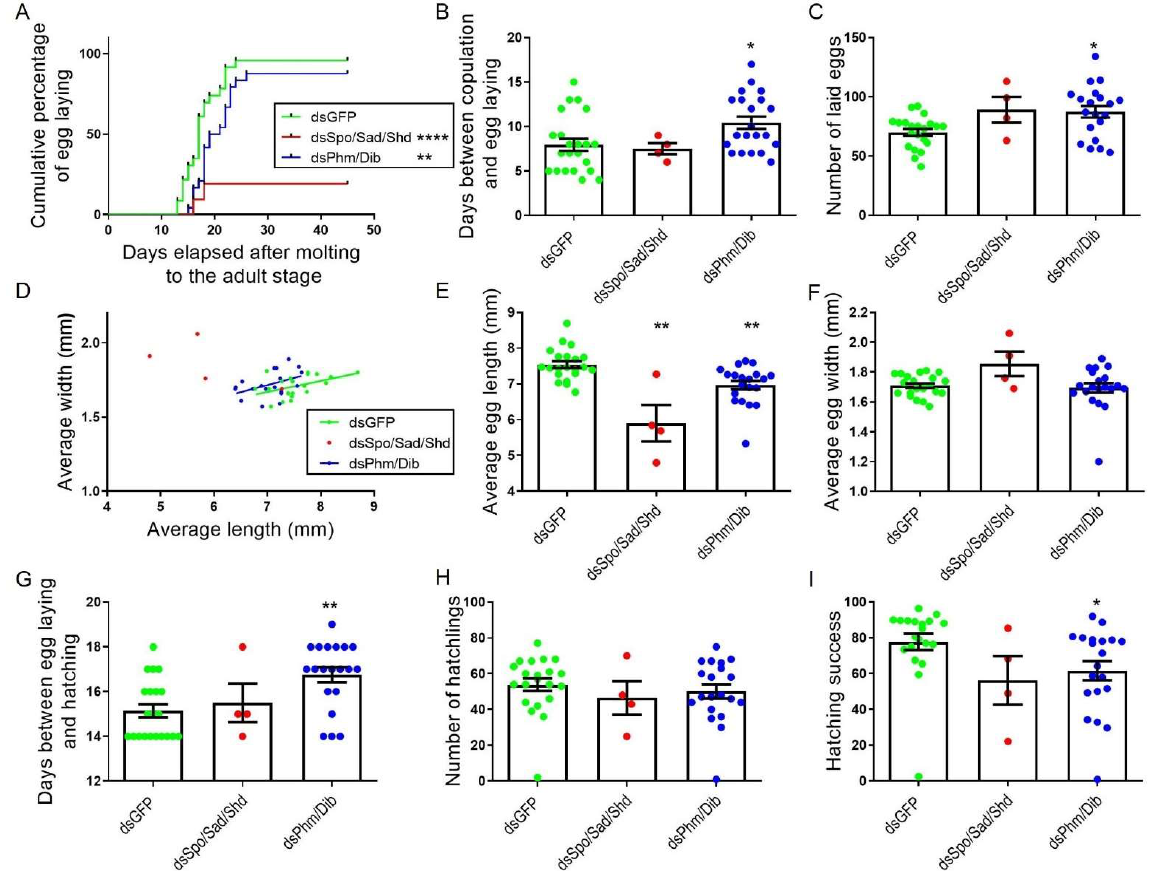
Figure 5. Effects of RNAi-mediated knockdown of SchgrSpo / SchgrSad / SchgrShd and SchgrPhm / SchgrDib on egg size, egg laying and hatching of female S. gregaria . ( A ) Cumulative percentage of egg laying by dsRNA-injected female locusts: 19.05% for dsSpo / Sad / Shd - ( n = 4), 87.5% for dsPhm / Dib - ( n = 24) and 95.65% for dsGFP -treated ( n = 23) females. The curves of dsSpo / Sad / Shd and dsPhm / Dib -treated females significantly differ from the curve of dsGFP -treated females (**** p < 0.0001 for dsSpo / Sad / Shd and ** p < 0.01 for dsPhm / Dib ; Mantel–Cox test). ( B ) The number of days between copulation and egg laying is presented as the mean ± S.E.M.; each dot represents one data point. Significant differences are indicated by (an) asterisk(s) (* p < 0.05; Kruskal–Wallis test with Dunn’s Multiple Comparisons test). ( C ) The number of eggs laid per condition is presented as the mean ± S.E.M.; each dot represents one data point. Significant differences are indicated by (an) asterisk(s) (* p < 0.05; Kruskal–Wallis test with Dunn’s Multiple Comparisons test). ( D ) The data represent the average length (Y-axis) and width (X-axis) of eggs laid by dsSpo / Sad / Shd -, dsPhm / Dib - or dsGFP -treated females (coloured dots), as well as the linear regression (coloured lines) ( dsSpo / Sad / Shd n = 4, dsPhm / Dib n = 20 and dsGFP n = 21). The Pearson‘s correlation coefficients for the dsSpo / Sad / Shd , dsPhm / Dib and dsGFP knockdown conditions are −0.6416 ( p = 0.3584), 0.4309 ( p = 0.0655) and 0.4624 ( p = 0.0348), respectively. ( E ) The average length of seven eggs per locust is presented as the mean ± S.E.M.; each dot represents one data point. Significant differences are indicated by (an) asterisk(s) (** p < 0.01; Kruskal–Wallis test with Dunn’s Multiple Comparisons test). ( F ) The average width of seven eggs per locust is presented as the mean ± S.E.M.; each dot represents one data point. ( G ) The number of days between egg laying and hatching is presented as the mean ± S.E.M.; each dot represents one data point. Significant differences are indicated by (an) asterisk(s) (** p < 0.01; Kruskal–Wallis test with Dunn’s Multiple Comparisons test). ( H ) The number of hatchlings per condition is presented as the mean ± S.E.M.; each dot represents one data point. ( I ) The hatching success percentage is presented as the mean ± S.E.M.; each dot represents one data point. Significant differences are indicated by (an) asterisk(s) (* p < 0.05; Kruskal–Wallis test with Dunn’s Multiple Comparisons